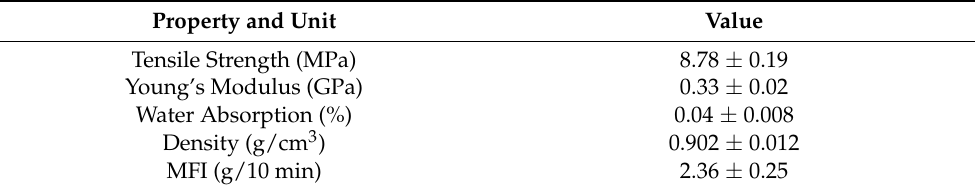
Table 1. Properties of rLDPE.